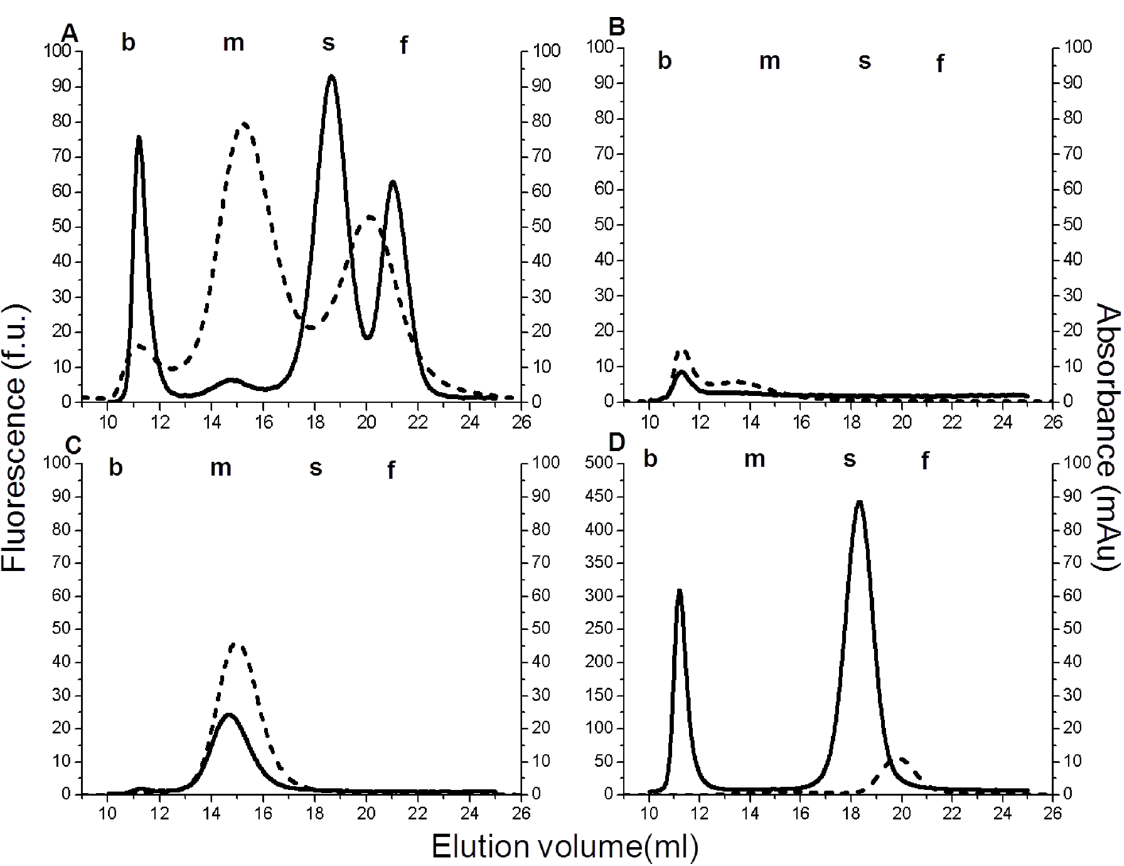
Figure 1. GGT-specific (continuous line) and total cholesterol (dashed line) elution profiles in a plasma pool (pool-1) representative of four experiments, and in the lipoprotein fractions isolated from it. A) Total plasma; B) VLDL (elution volume: 11.3 ml; density 0.950– 1.006 g/ml; Stokes radius: 30–80 nm); C) LDL (15.0 ml; 1.006–1.063 g/ml; 18–25 nm); D) HDL (20.0 ml; 1.063–1.21 g/ml; 8–11 nm). Lipoproteins were separated by ultracentrifugation on a NaBr discontinuous density gradient. Elution profiles were obtained by size-exclusion chromatography associated with a post-column reaction specific for GGT or total cholesterol.